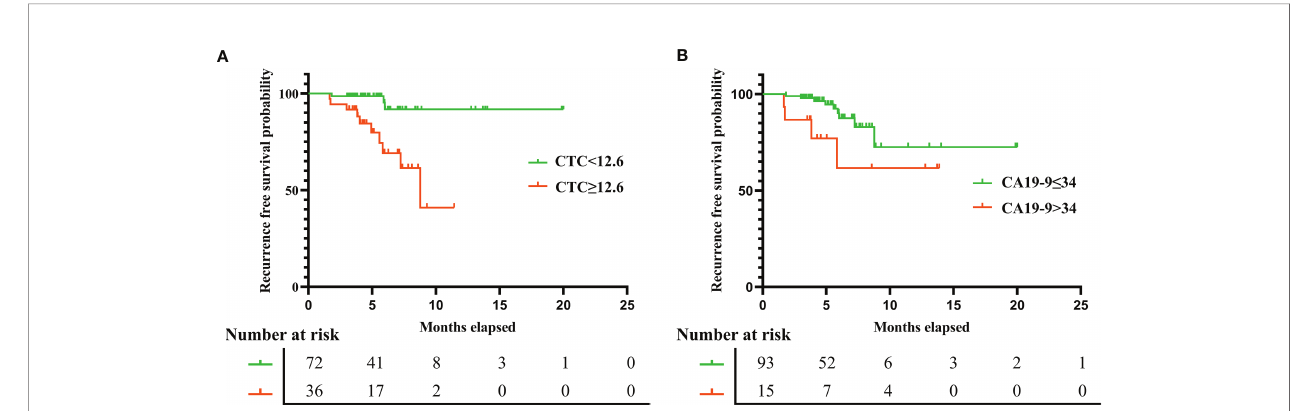
FIGURE 4 | The recurrence free survival rate in gastric cancer patients based on preoperative FR+ CTCs level (A) and serum CA19-9 level (B) . FR+CTCs, folate receptor-positive circulating tumor cells; CA19-9, carbohydrate antigen